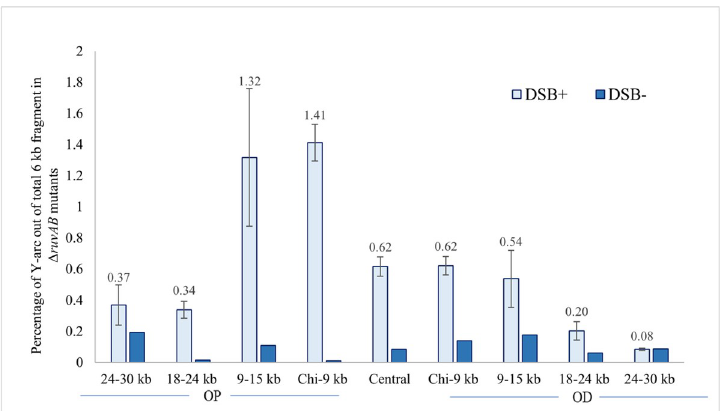
Fig 6. Distribution of 3-way DNA structures across the lacZ region of Δ ruvAB mutant strains as a function of induction of DSB repair. Quantification of the signal intensities of 3-way DNA structures generated across the 60kb region following a DSB. This analysis was carried out on non-crosslinked DNA samples and 3-way DNA structures were quantified as the percentage of Y-arc out of the total 6kb DNA fragment (DSB + ). The quantification of Y-arcs from control blots (2-D gel analysis of non-crosslinked DNA fragments isolated from bacterial cell culture grown in presence of glucose) is also shown (DSB-). The strains used were DL7271 ( Δ ruvAB 24-30kb OP), DL7270 ( Δ ruvAB 18- 24kb OP), DL7259 ( Δ ruvAB 9-15kb OP), DL7253( Δ ruvAB Chi-9kb OP), DL7272 ( Δ ruvAB Chi-Chi), DL7251 ( Δ ruvAB Chi-9kb OD), DL7258 ( Δ ruvAB 9-15kb OD), DL7261 ( Δ ruvAB 18-24kb OD) and DL7262 ( Δ ruvAB 24-30kb OD). OP and OD represent origin-proximal and origin-distal sides. Error bars represent the standard error of the mean where the number of replicates for DSB + strains is 3 and DSB - strains is 1.